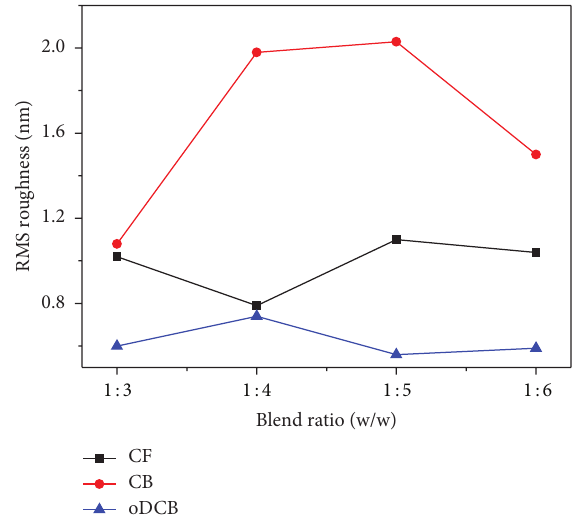
Figure 5: Absorption spectra of active layer of PCDTBT: PC 71 BM prepared by using organic solvents of chloroform, chlorobenzene, and o-dichlorobenzene with PCDTBT: PC 71 BM ratios of (1: